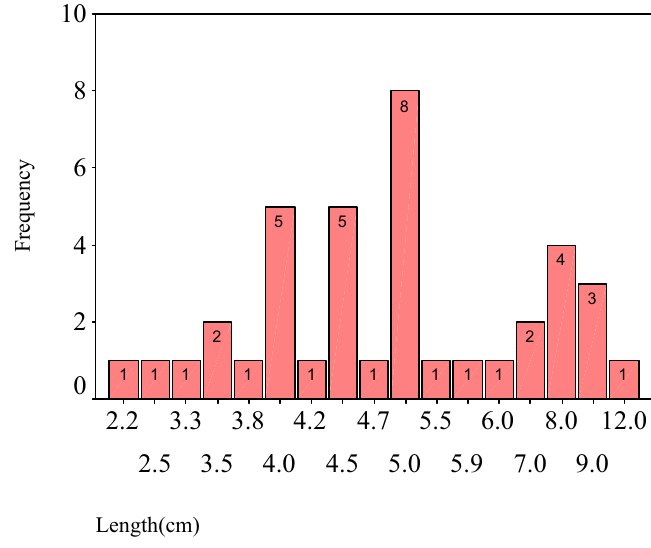
FIGURE 3 - Pedicle length of SIEV (n=39)